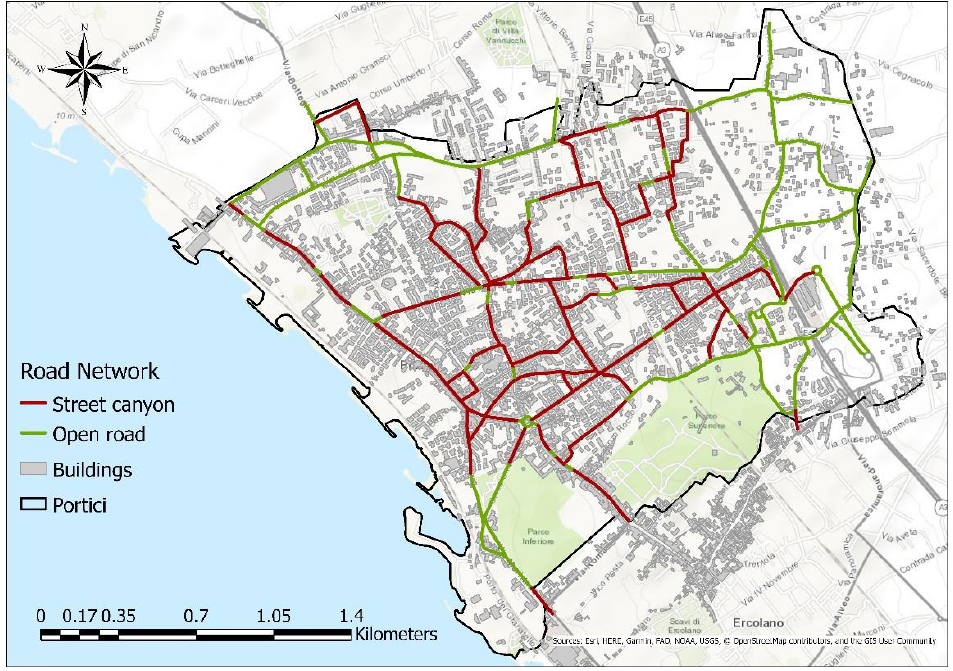
Figure 5. Layer of road network classified on the street canyon and open road conditions.